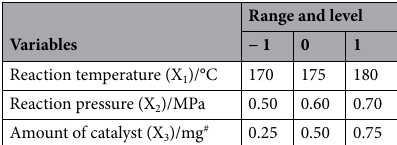
Table 1. Experimental range and levels for Box–Behnken design. a Amount of catalyst = amount of Mn